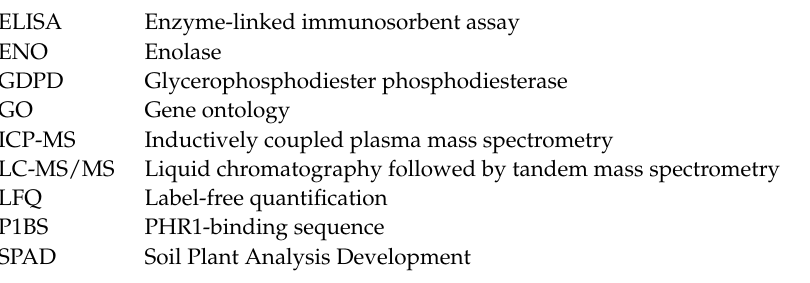
Supplementary Materials: The following are available online at https://www.mdpi.com/1422-006 Table S2: Alignment of the amino acid sequences of ENO proteins in Arabidopsis, rice, and soybean. Table S3: List of primers used in this